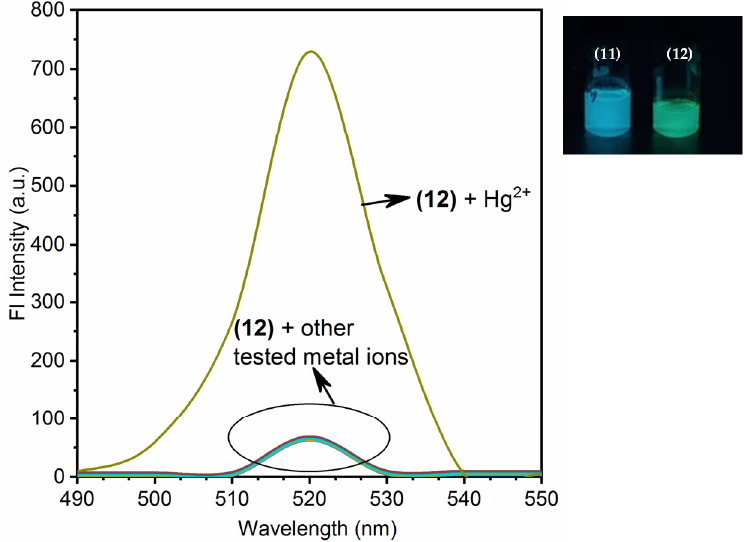
Figure 2. Fluorescence response of (12) (10 ppm) towards various cations at excitation of 290 nm (Inset: image of nano-composite (11) and (12) on addition of Hg 2+ ions).